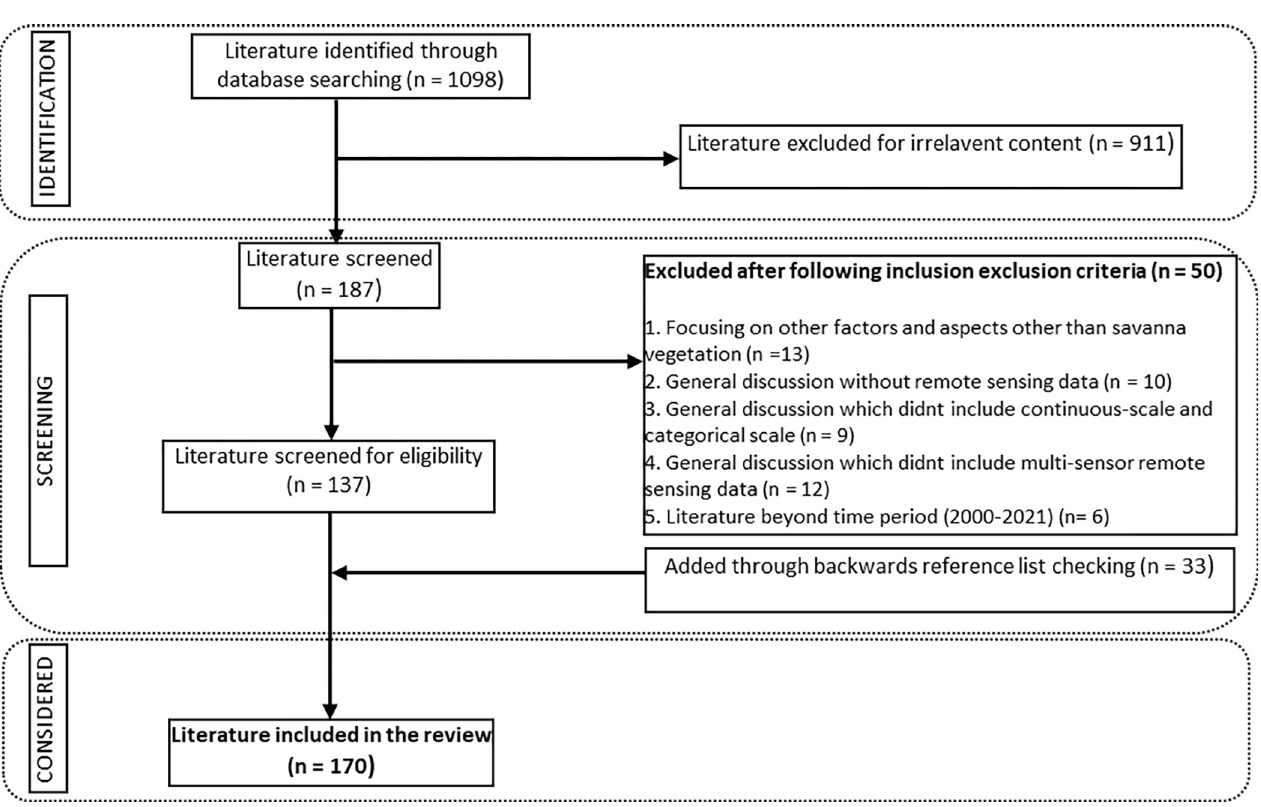
Fig 1. Literature selection process using Preferred Reporting Items for Systematic Reviews and Meta-Analyses (PRISMA) framework.